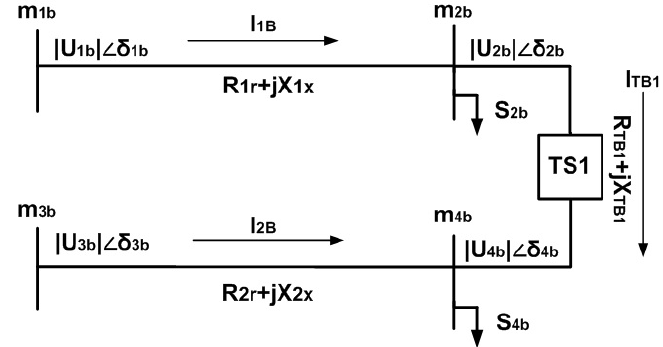
Figure 1. The electrical equivalent diagram of loop distribution system.